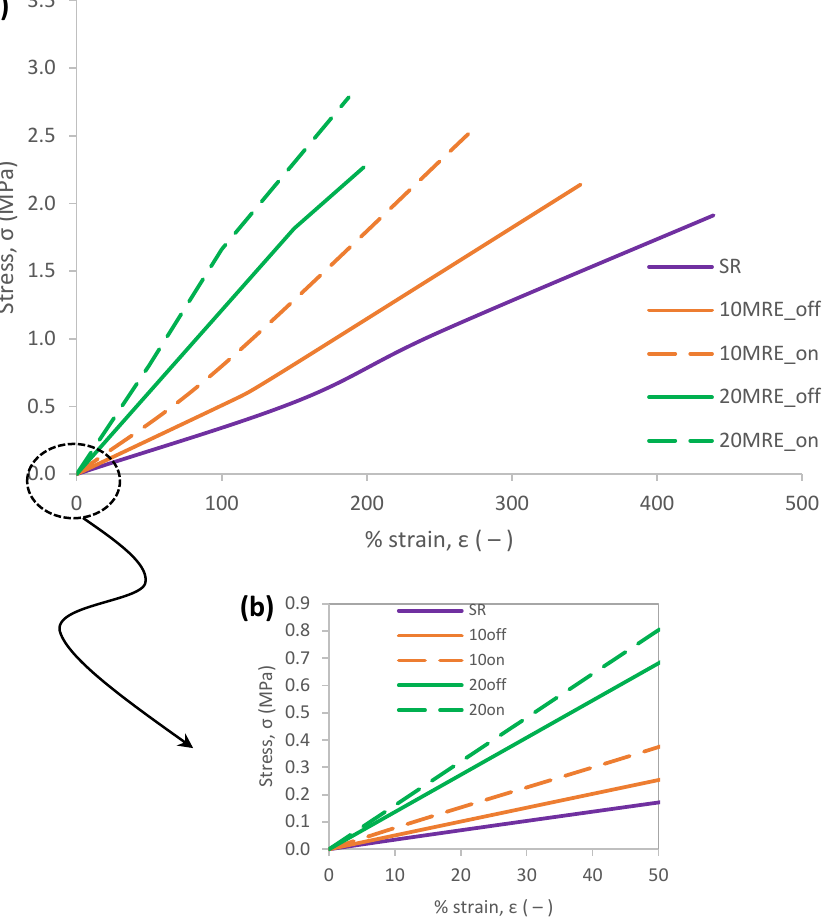
Figure 3. ( a ) Total strain and ( b ) magnification at 50% strain on stress–strain results of a quasi-static uniaxial tensile test of pure SR, MREs at 10 vol.%, CIPs and MREs at 20 vol.%, and CIPs with and without magnetic fields.